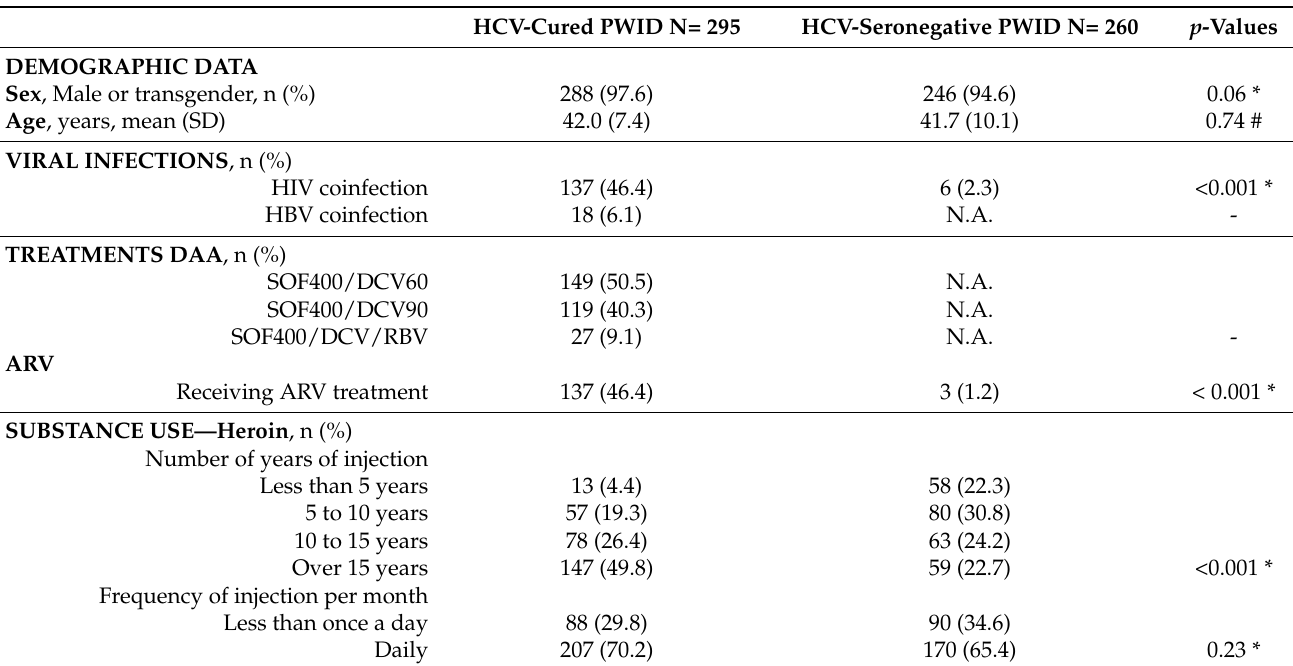
Table 1. Baseline characteristics of PWID included in the analysis and compared to HCV- seronega- tive